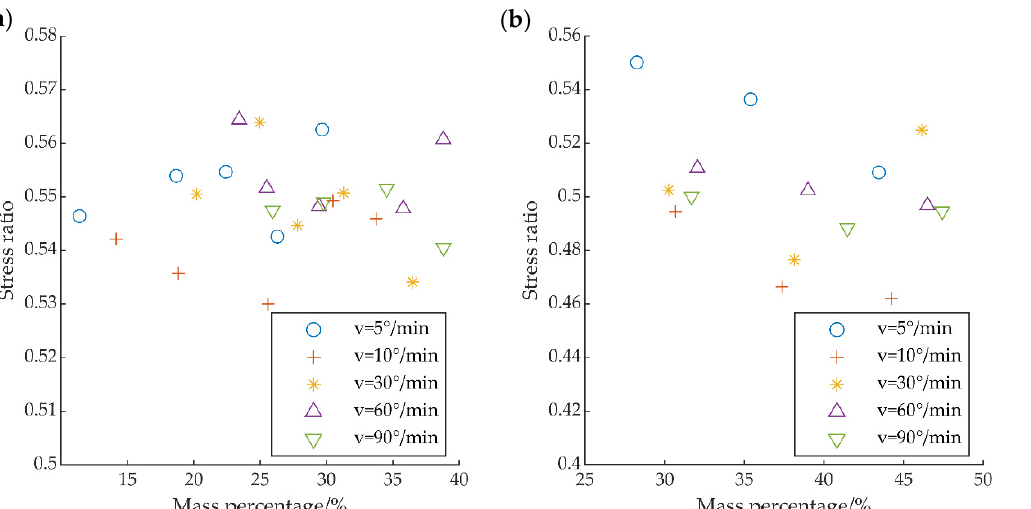
Figure 5. Typical shear stress curves and local magnification. Quartz sand, v = 30°/min.